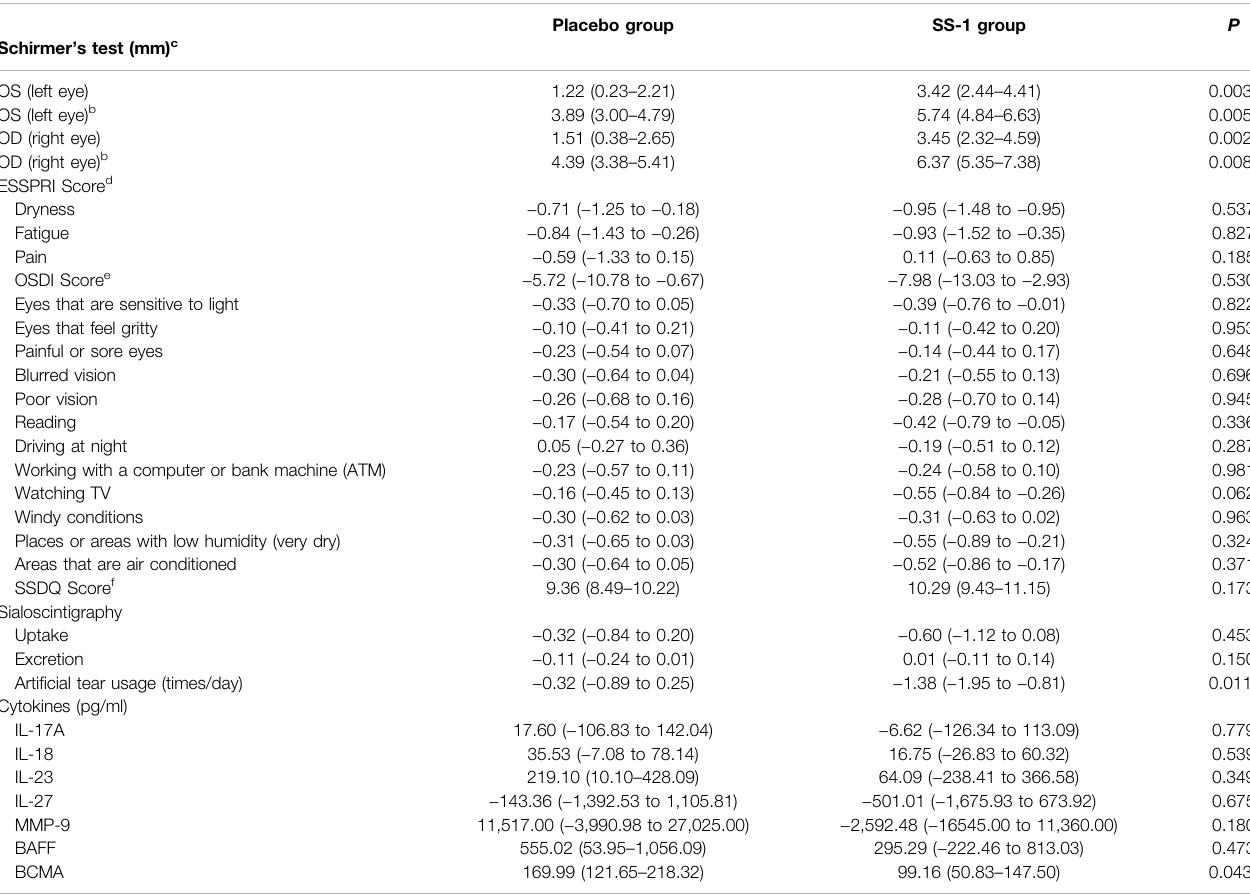
TABLE 2 | The clinical outcome of the SS-1 trial for Sjögren ’ s syndrome patients.